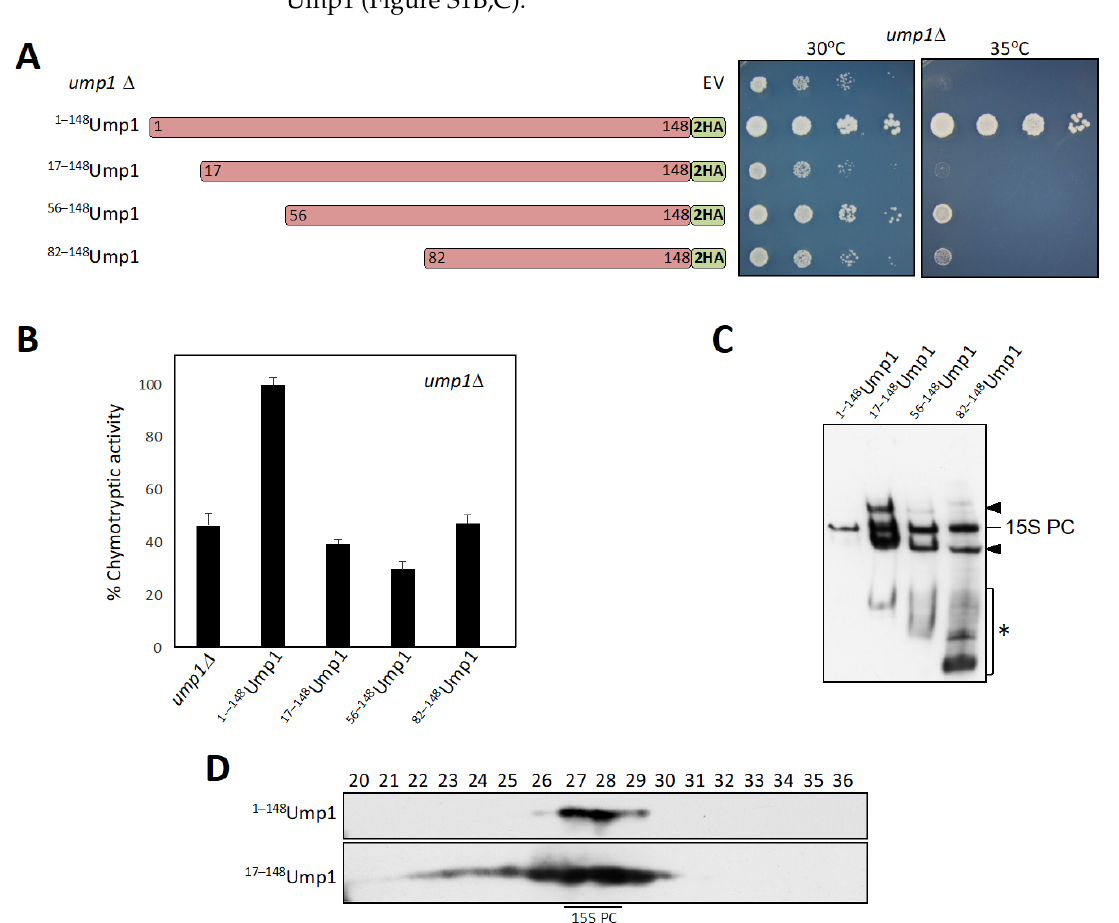
Figure 1. N-terminally truncation of Ump1 leads to functional impairment. ( A ) Yeast ump1 ∆ cells expressing N-terminally truncated Ump1 display poor and temperature-sensitive growth. On the left, HA-tagged version of Ump1 encoded by low copy ( CEN ) plasmids under control of the P UMP1 promoter are depicted. Ump1 ∆ cells were transformed either with CEN plasmids encoding the depicted Ump1 variants or with the empty vector (EV). Exponentially growing cultures of the transformants were serially (1:10 steps) diluted, spotted onto selective minimal (SD) media, and incubated for 2 days at the indicated temperatures (right part). ( B ) N-terminal truncation of Ump1 leads to reduced proteasomal chymotryptic (CT) activity. Exponentially growing cells expressing the indicated Ump1 versions (same as in ( A )) were harvested in triplicates and the CT activity was measured in native extracts. Depicted are the mean activities with standard deviations. The mean of the values for the transformants with full-length Ump1 was set to 100%. ( C ) Native PAGE analysis of complexes containing Ump1 variants. The same extracts as used in ( B ) were separated by native PAGE and analyzed by anti-HA Western blotting. The position of the 15S PC is indicated. Arrowheads, additional complexes described in the main text. *, lower molecular weight forms containing truncated Ump1 variants. Ponceau S staining of the membrane as a loading control is provided in Figure S6. ( D ) Gel filtration analysis of complexes present in extracts from cells expressing either full-length Ump1-HA or truncated 17–148 Ump1-HA. Protein extracts were separated on a Superose 6 column, and 0.5 mL fractions were collected. Chromatograms are provided in Figure S7. Fractions from 20 to 36 were analyzed by SDS-PAGE and anti-HA Western